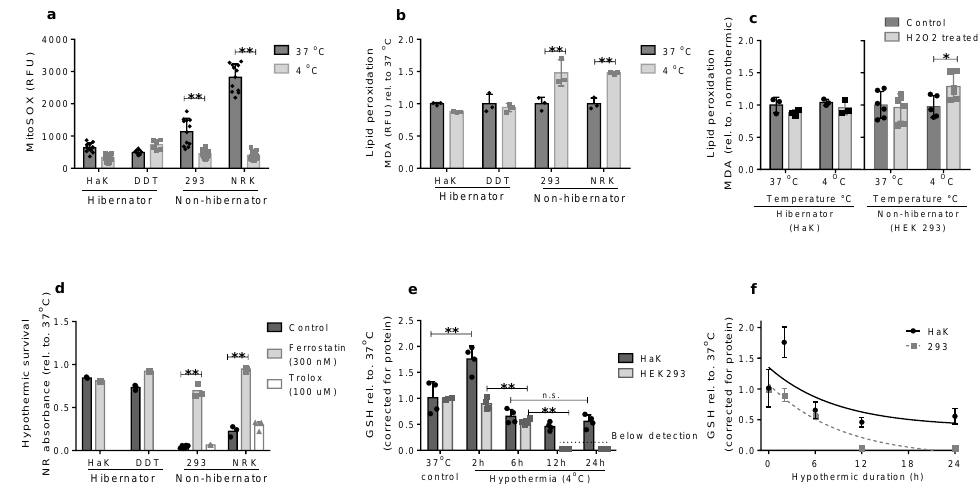
Figure 3. Oxidative damage after hypothermia. ( a ) Superoxide production in normothermic and hypothermic cells, measured by MitoSOX. ( b ) Lipid peroxidation levels induced by hypothermia (4 °C 6h), measured by malondialdehyde (MDA). ( c ) MDA levels in HaK and HEK293 cells after exogenous H 2 O 2 exposure in normothermic and hypothermic circumstances. ( d ) Survival after hypothermia expressed as relative NR absorbance to 37 °C control. ( e ) Reduced glutathione (GSH) levels during hypothermia. Expressed as relative levels to 37 °C. ( f ) GSH decline during hypothermia, non-linear fit. The T-test for the area under the curve is statistically different at p < 0.001. All data presented as mean ± SD. * = p < 0.05, ** = p < 0.01; ANOVA post hoc Bonferroni. n.s. = non-significant